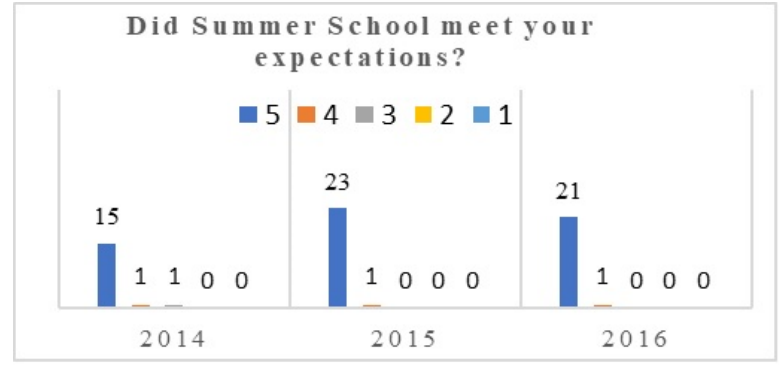
Figure 12. Survey results from 2014–2016 (answers on the scale from 5—fully to 1—not at all).